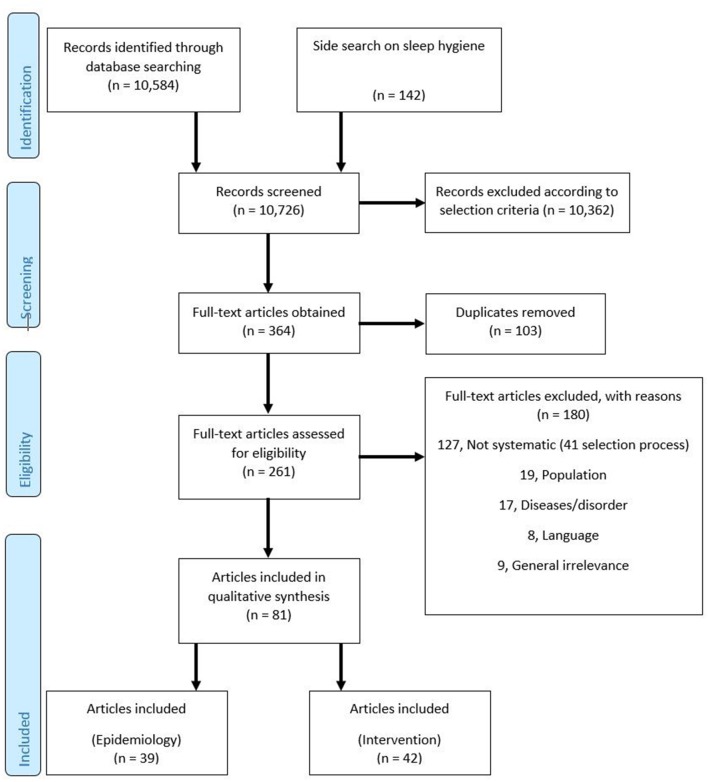
PRISMA flow diagram.